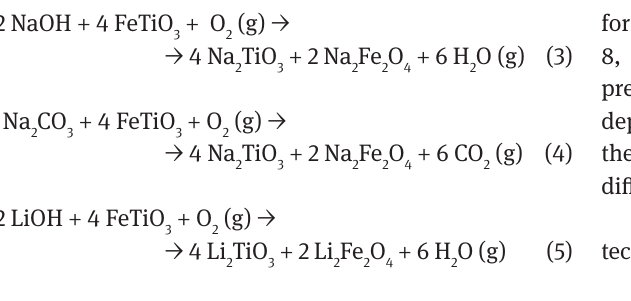
Figure 4: XRPD patterns comparison of the magnetic and non magnetic fractions of Bomar